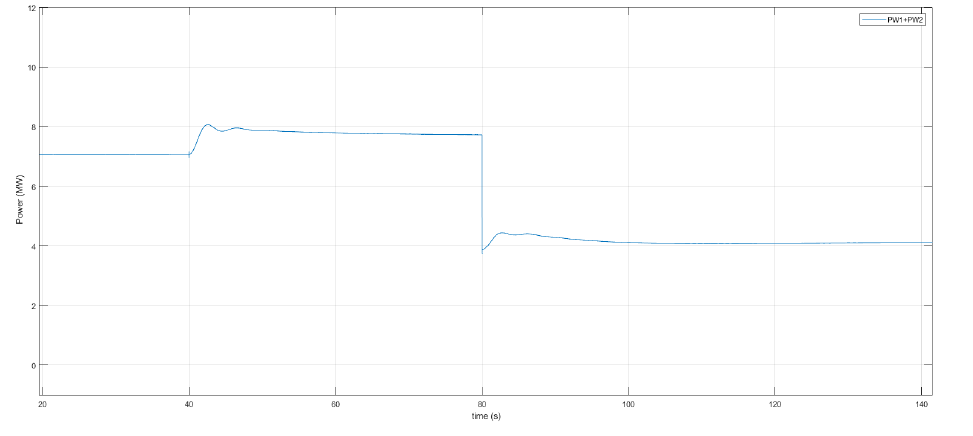
Figure 12. The active power generated by DVPP unit.